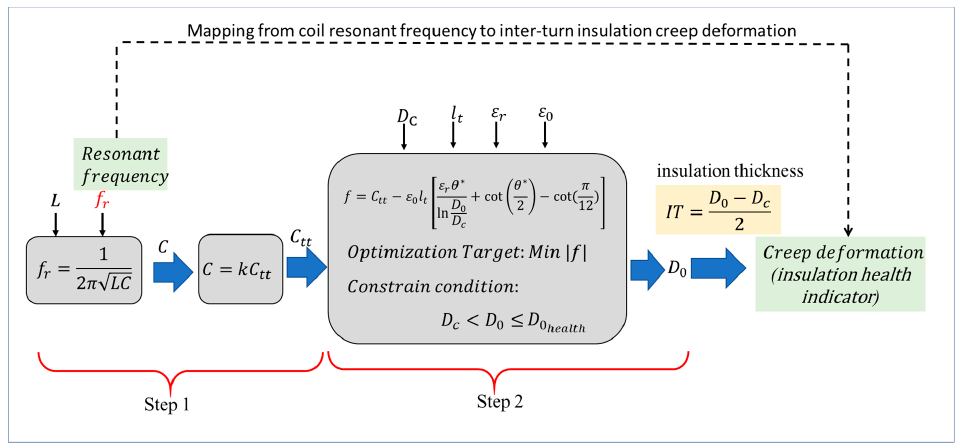
Figure 8. Framework for mapping from coil resonant frequency to inter-turn insulation creep deformation.